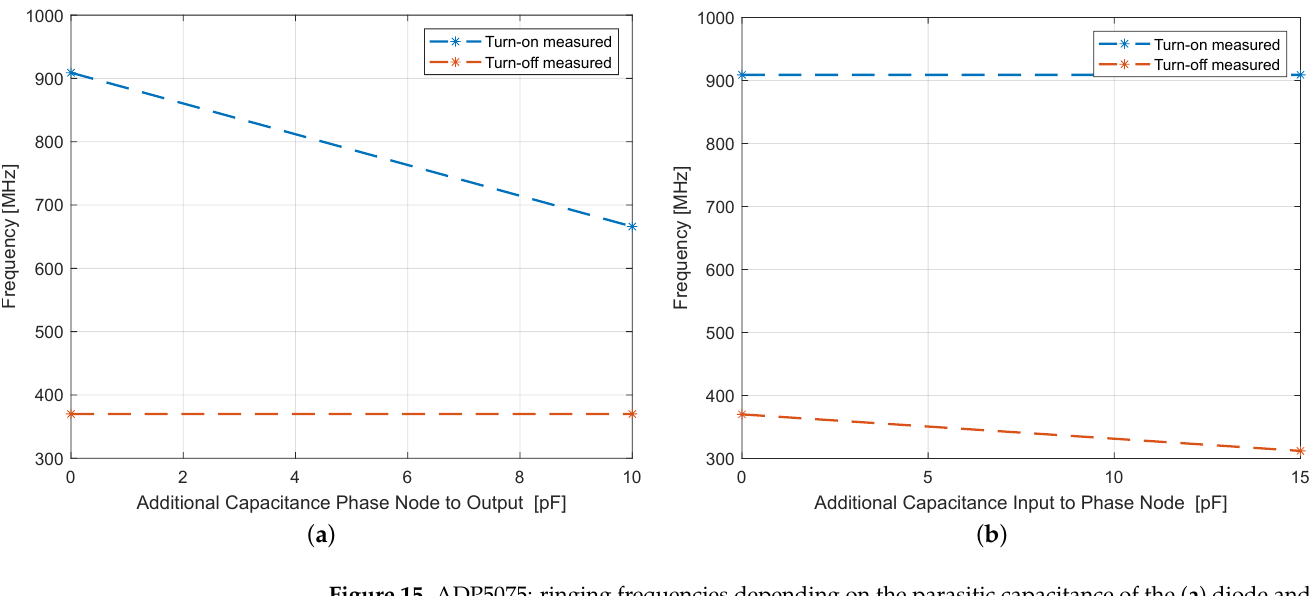
Figure 15. ADP5075: ringing frequencies depending on the parasitic capacitance of the ( a ) diode and ( b ) the MOSFET.